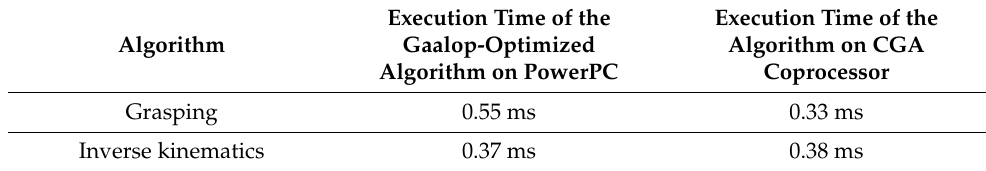
Table 14. Gaalop/CGA coprocessor